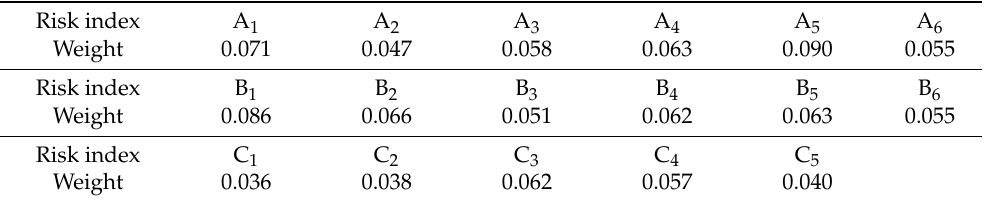
Table 4. Weights of Shanghai ICCL Safety Supervision